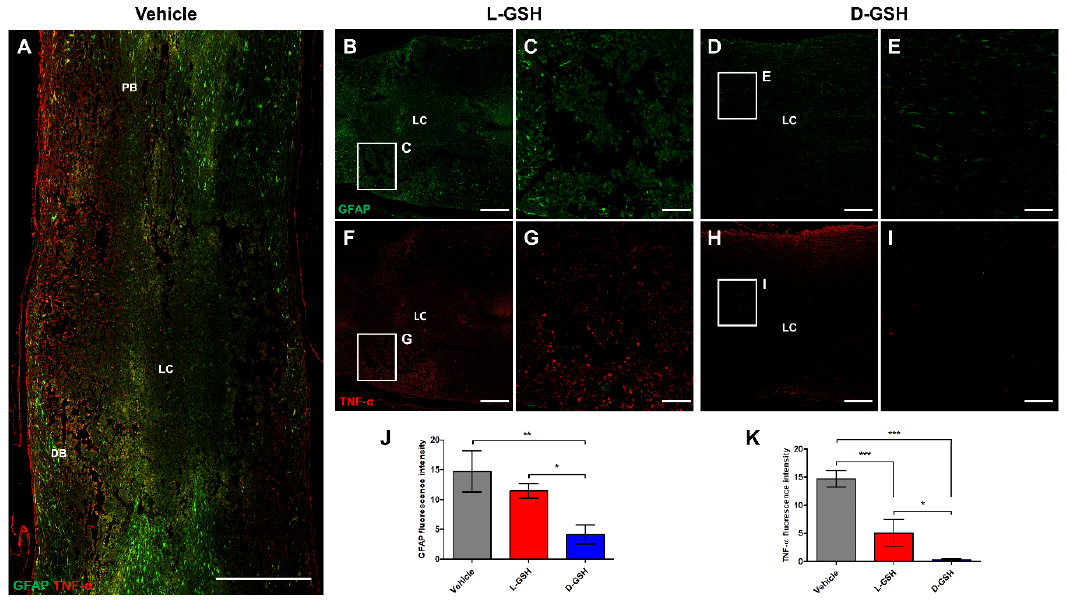
Figure 3. Immunofluorescence analysis in composite tiled scans of sagittal sections stained for glial scar (anti-glia fibrillary acidic protein, GFAP, Green), inflammatory cytokine (anti-tumor necrosis factor- α , TNF- α , Red). Proximal border (PB) and distal border (DB) away from the lesion center (LC). ( A ) Representative merged image for GFAP and TNF- α in the vehicle group. ( B ) Representative image for GFAP in the L-GSH group. ( C ) Higher magnification of the proximal border (boxed area) from ( B ). ( D ) Representative image for GFAP in the D-GSH group. ( E ) Higher magnification of the proximal border (boxed area) from ( D ). ( F ) Representative image for TNF- α in the L-GSH group. ( G ) Higher magnification of the proximal border (boxed area) from ( F ). ( H ) Representative image for TNF- α in the D-GSH group. ( I ) Higher magnification of the proximal border (boxed area) from ( H ). Scale bar, 500 μ m ( A , B , D , F , H ) and 100 μ m ( C , E , G , I ). Quantitative analyses of the fluorescence intensity for ( J ) GFAP and ( K ) TNF- α . Results are the mean ± standard error of the mean (SEM); * p < 0.05, ** p < 0.01, and *** p < 0.001; one-way ANOVA with Tukey post hoc test.